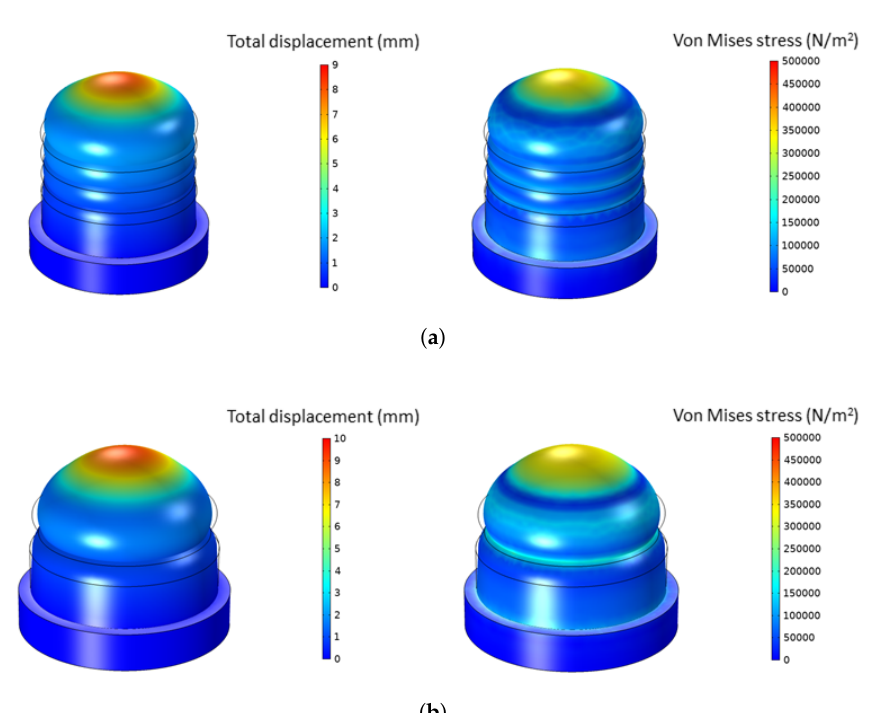
Figure 2. Model showing the displacements reached and the von Mises stress under 50 kPa pressure: ( a ) 4-bellows soft actuator; and ( b ) 2-bellows soft